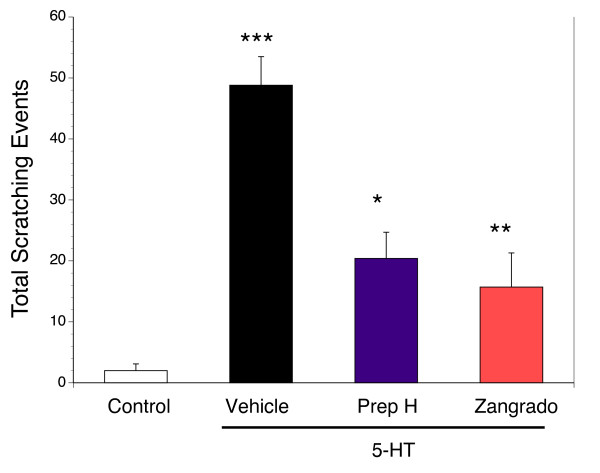
Anti-pruretic effects between Zangrado and a commercial hemorrhoid crème. Subcutaneous 5-HT administration (black column, n = 11) evoked a significant scratching response over saline (control, *** p < 0.001). This scratching response was significantly attenuated by either topical administration of Preparation H (Prep H, purple column, * p < 0.01, n = 7) or Zangrado (red column, ** p < 0.001, n = 10), when applied immediately after the administration of 5-HT.